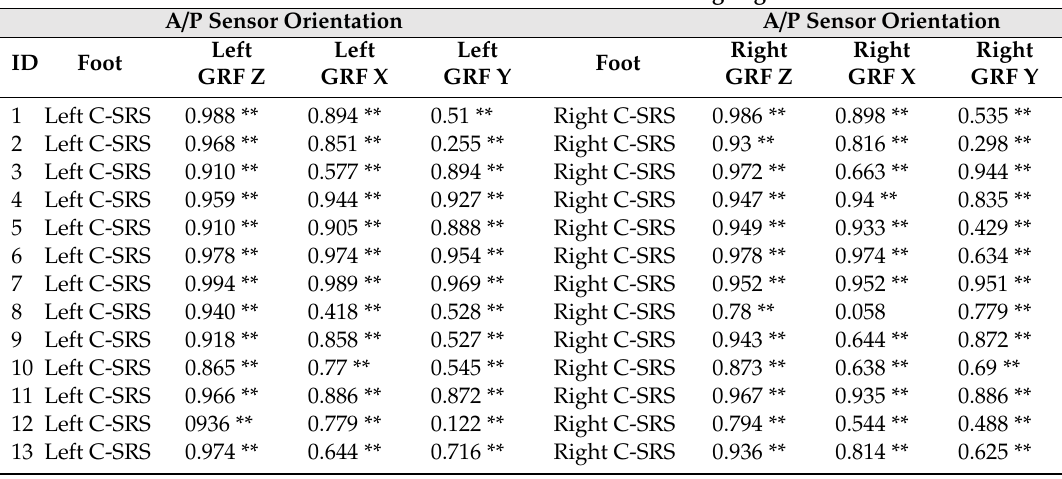
Table 2. Pearson correlation coe ffi cients comparison of C-SRSs and force plate during right and left